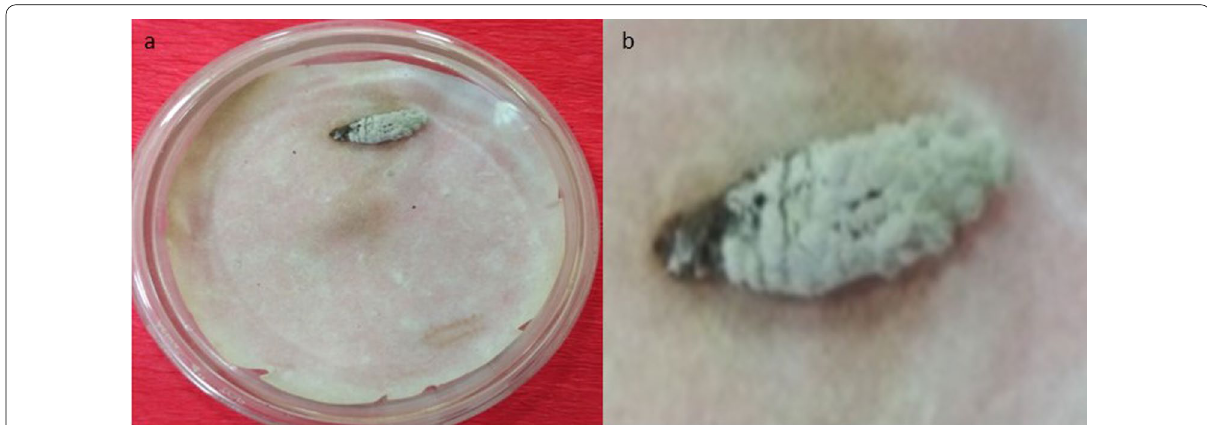
Fig. 1 Isolation of entomopathogenic fungi, Purpureocillium lilacinum by Galleria bait method a Growth of P. lilacinum on Galleria mellonella larvae, b Magnified view of the P. lilacinum covering the dead